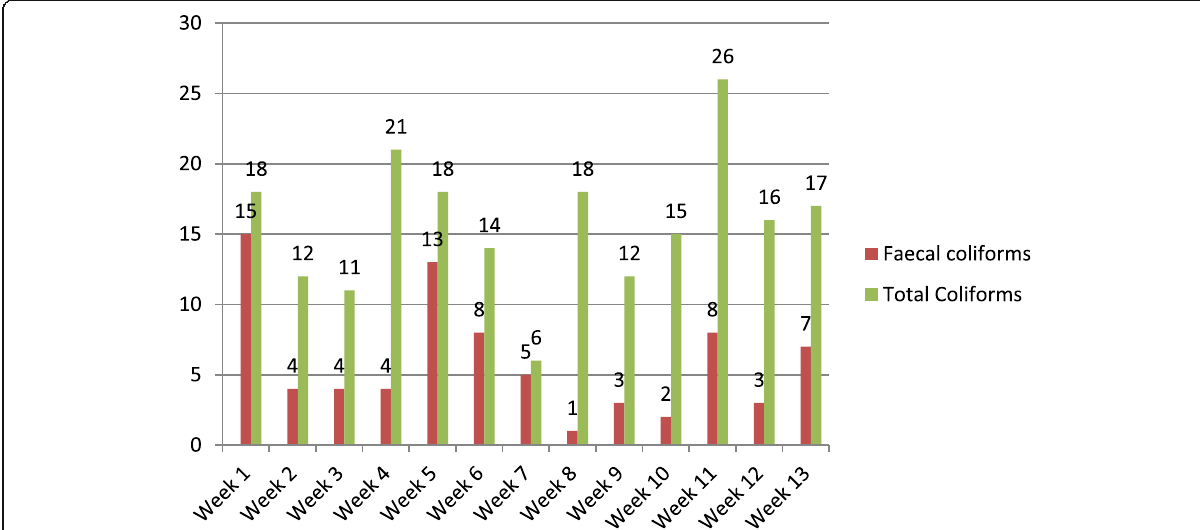
Fig. 1 The trends of bacterial distribution during the study period of the wet season in the four sources of Addis Ababa City Administration,